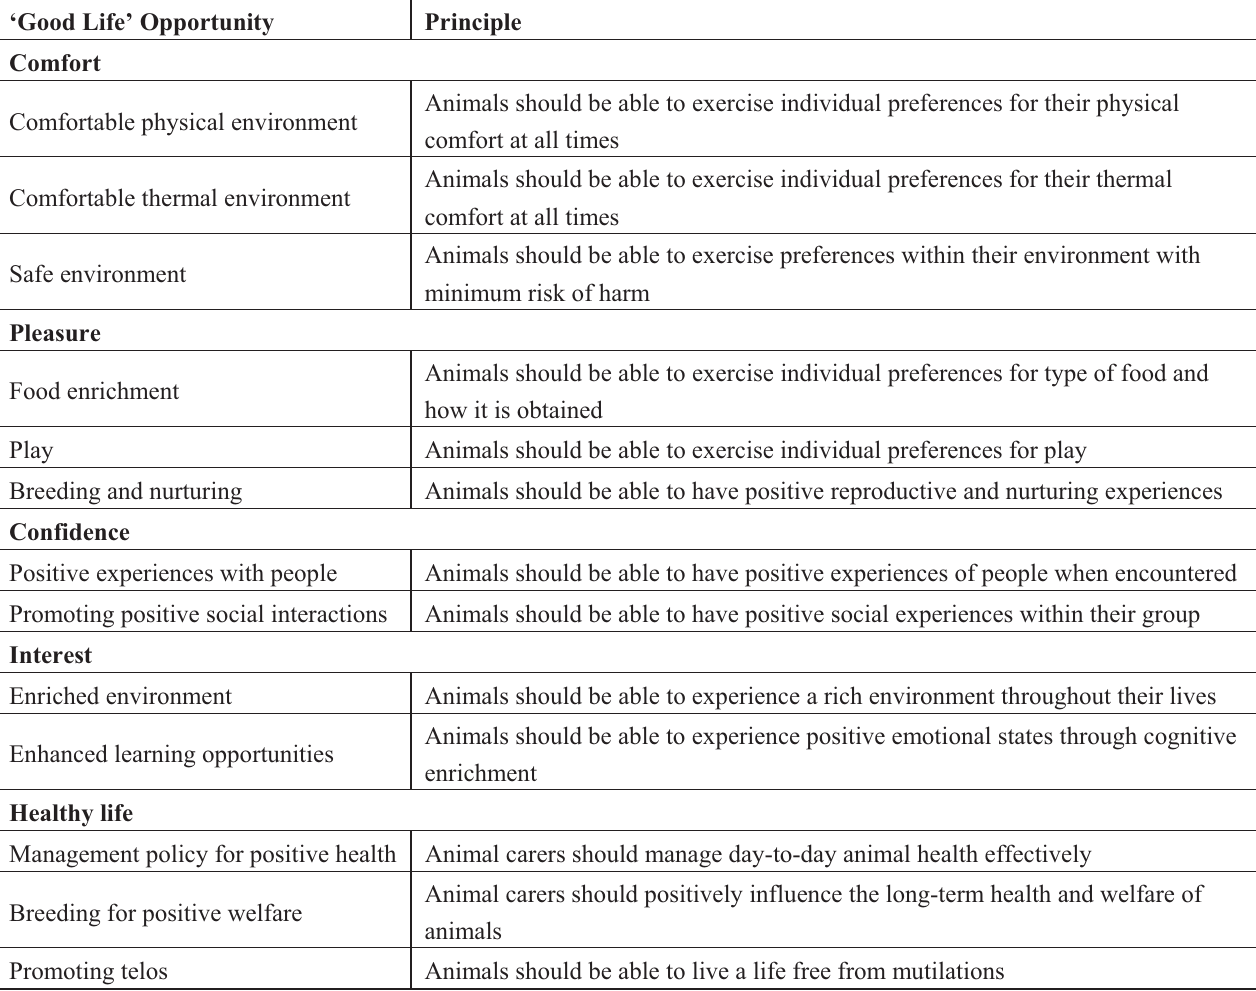
Table 4. Generic ‘good life’ opportunities and principles for farm